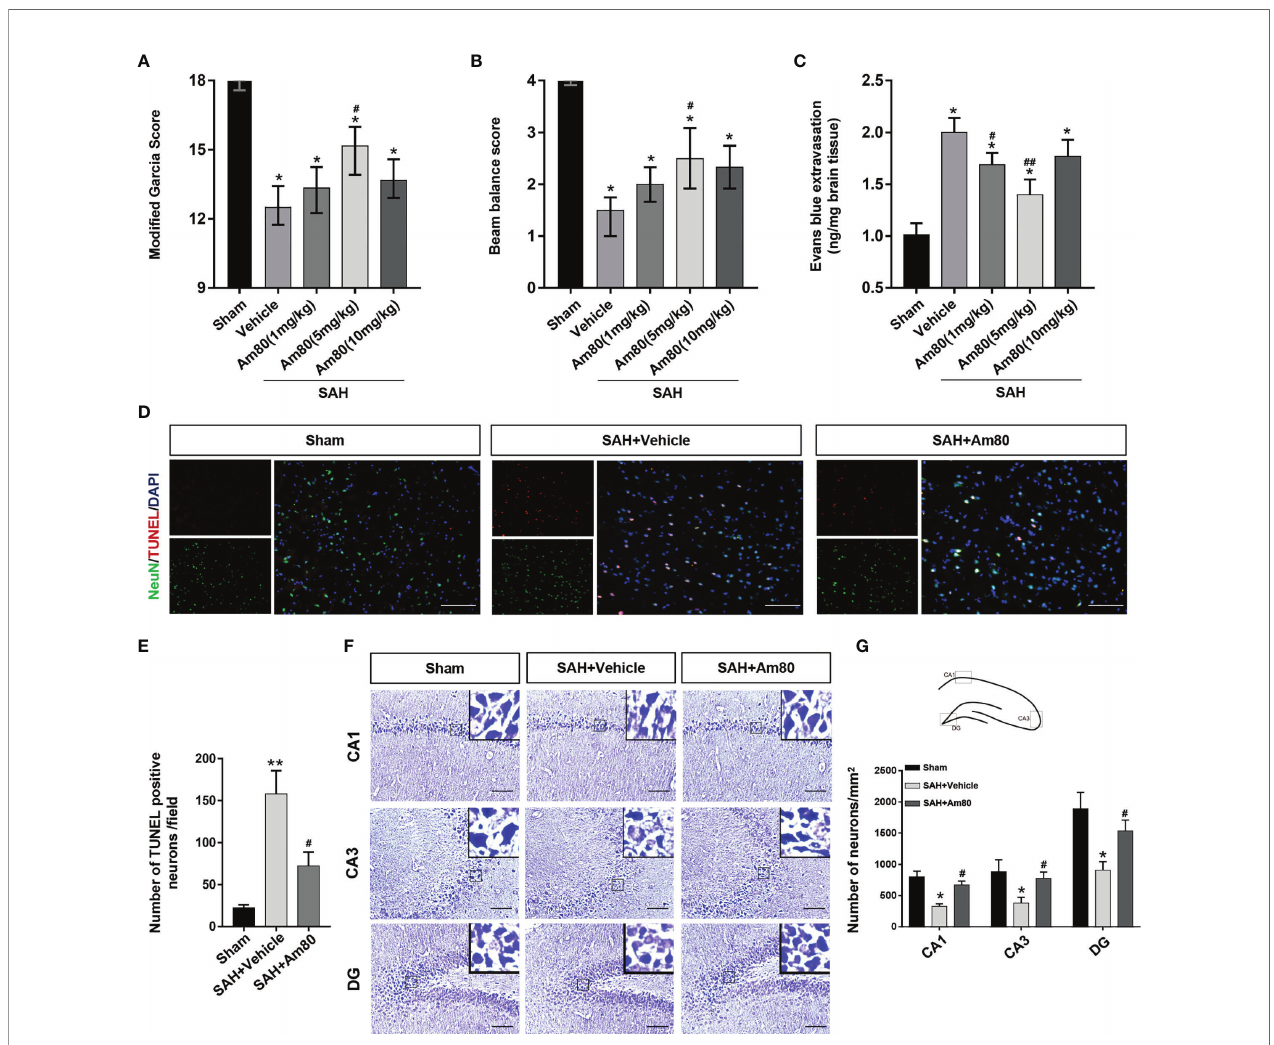
FIGURE 3 | Am80 attenuated neurological de fi cits, neuronal apoptosis, and BBB permeability at 24 h after SAH. Moreover, Am80 reduced hippocampus injury 14 days after SAH. (A, B) The modi fi ed Garcia and beam balance scores of each group. n = 6 per group. (C) Quanti fi cation of Evans blue extravasation at 24 h after SAH. (D) Representative images of TUNEL staining (red) in neurons (NeuN, green). (E) Quantitative analyses of TUNEL-positive cells. Scale bar = 100 m m. n=3 per group. (F) Representative images of Nissl staining in the CA1, CA3, and DG regions. (G) Upper middle indicates the hippocampus division and location of staining. Quantitative analyses of Nissl staining. n=3 per group. Scale bar = 100 m m. * P < 0.05 vs sham group; ** P < 0.01 vs sham group; # P < 0.05 vs SAH+vehicle group; ## P < 0.05 vs SAH+vehicle